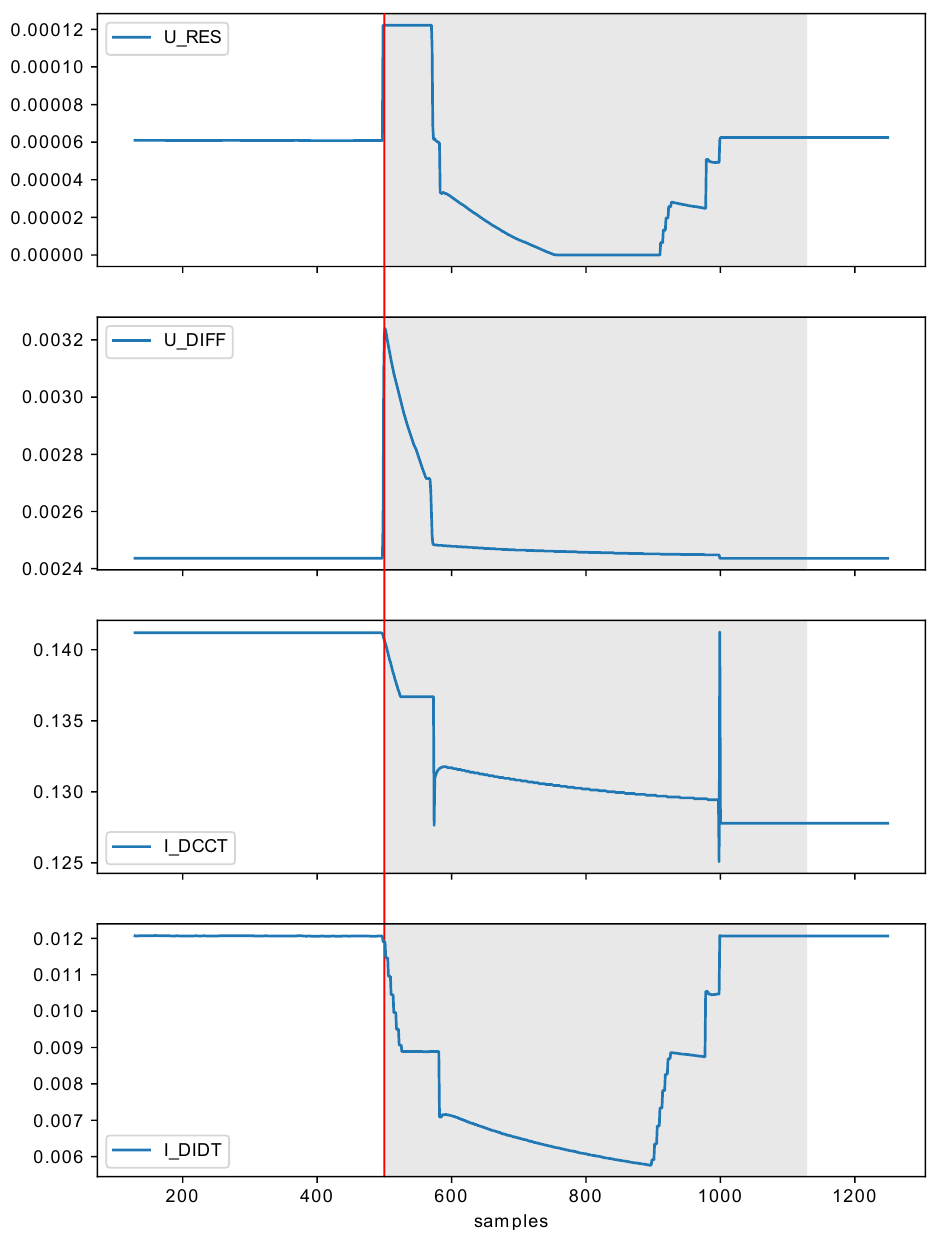
Figure 10. Example single series results visualization ( in _ grid = 32, in _ algorithm = recursive_adaptive , look _ back = 128). Red line across all subplots marks the QUENCHTIME and gray spans indicate the anomalies found by the